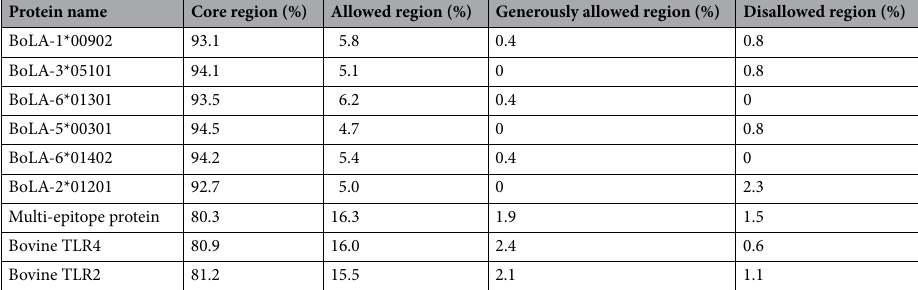
Table 3. Prediction of stability of modeled protein structure by Ramachandran plot.